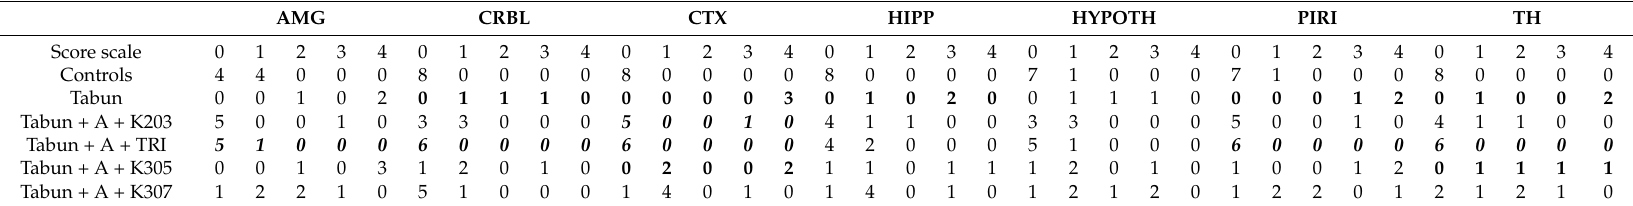
Table 4. Score of tabun-induced histopathological damage in rat brain and its modulation by different therapeutic approaches.